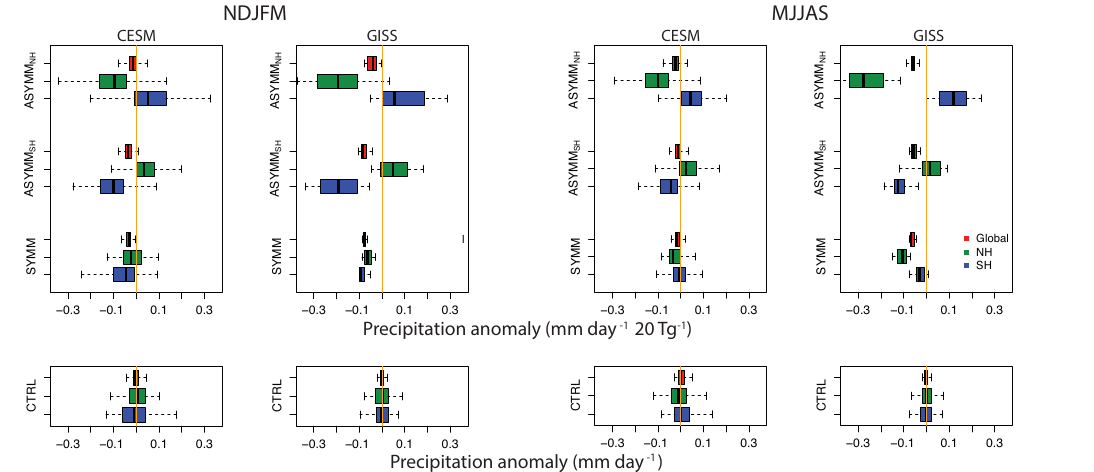
Figure 5. As in Fig. 3, except for precipitation (mmday − 1 , normalized to 20Tg in the forced simulations; mmday − 1 in the control). N (not shown) is the same as in Fig.